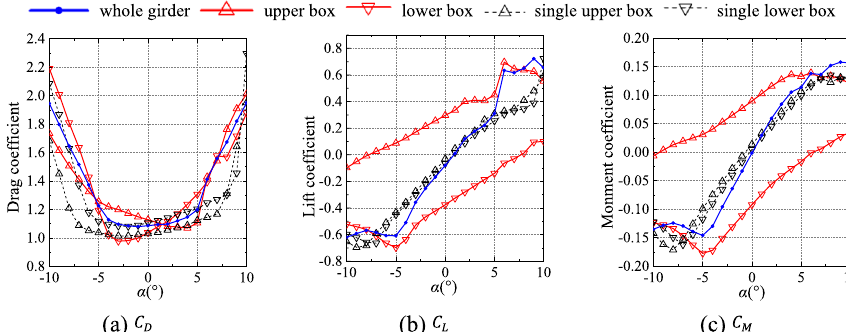
Fig. 6 Aerodynamic coefficients of the double-deck box girder